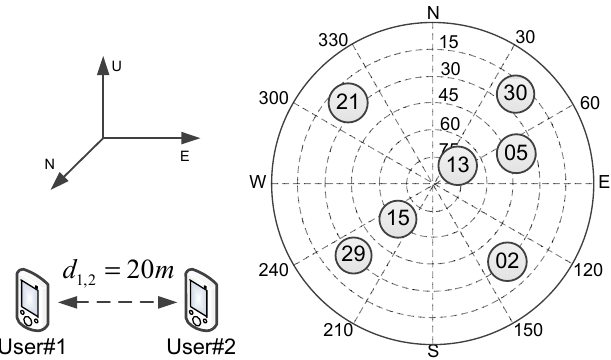
Figure 2. User distribution and skyplot of the outdoor simulation scenario.